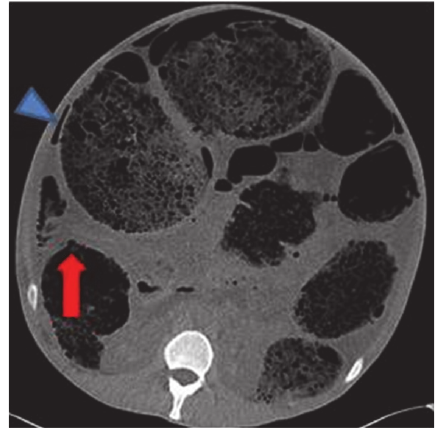
Figure 6: Axial CT images on lung windows confirming small pockets of free gas adjacent to the perforation